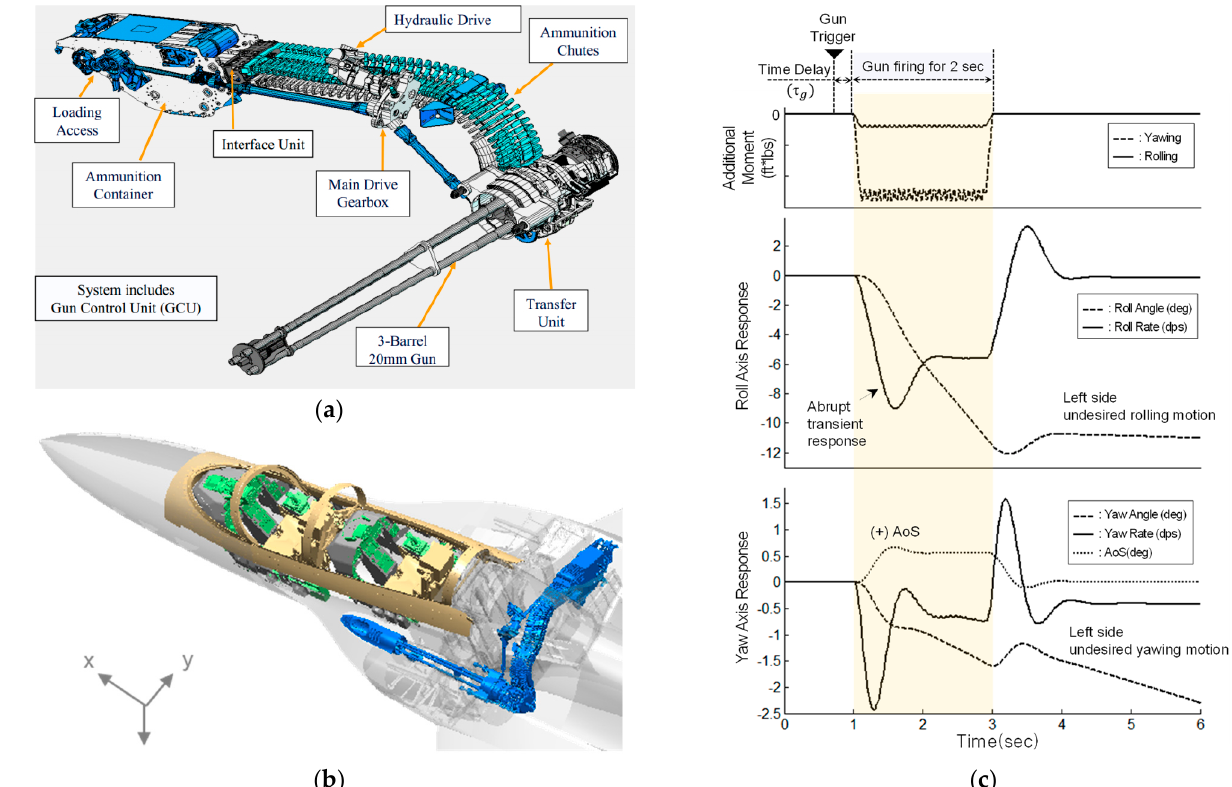
Figure 1. A-50 gun system and transient effect during gun firing: ( a ) gun system; ( b ) gun system layout; ( c ) undesired rolling and yawing transient motion during gun fi ring [12].